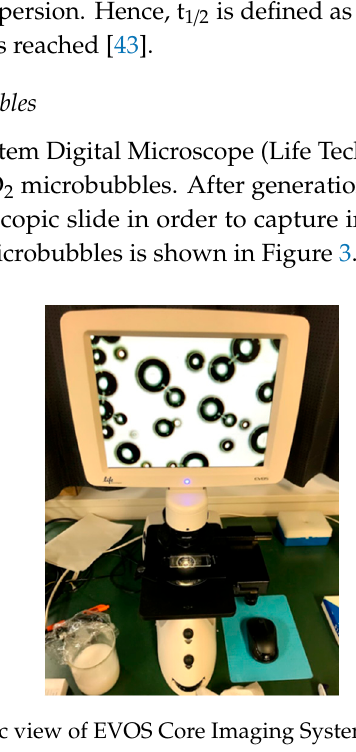
Figure 3. Schematic view of EVOS Core Imaging System Digital Microscope.